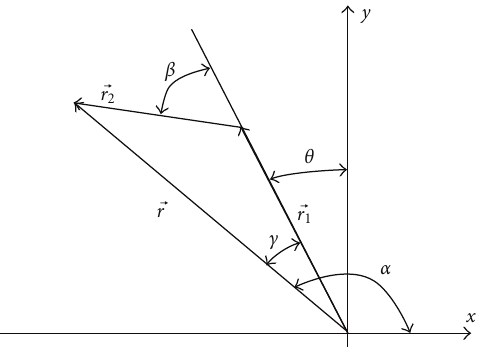
Figure 6: Mobile robot